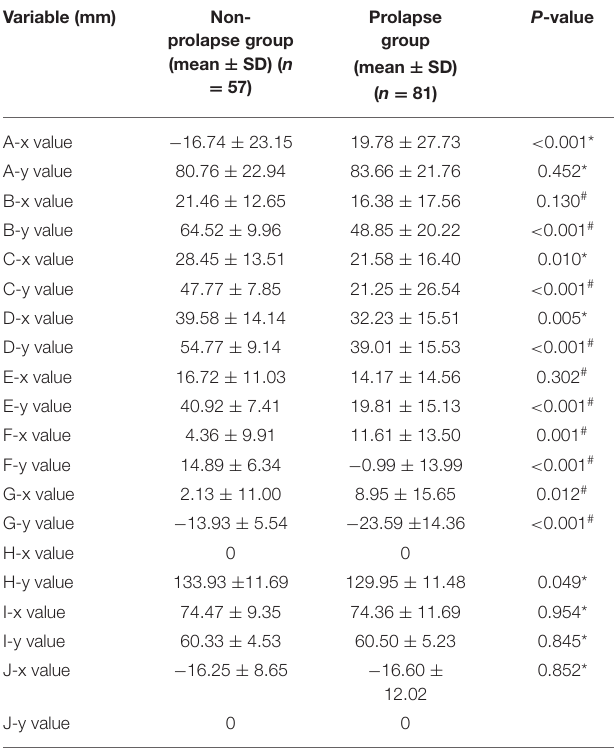
TABLE 4 | Coordinate parameters of the uterus and vagina. Variable